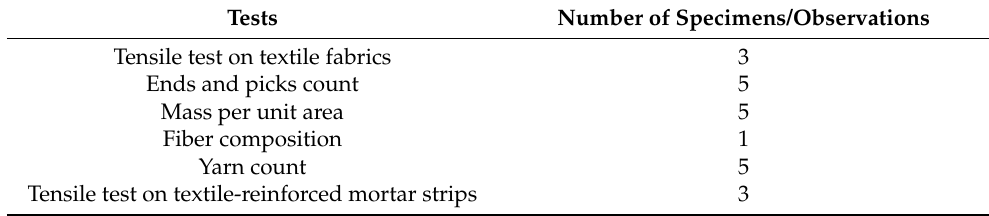
Figure 3. Counting of ends and picks (horizontal direction is the warp direction) ( a ) pick counter (TF9 specimen) ( b ) graduations of pick counter with raveled fabric (TF9 specimen). Table 4. Test